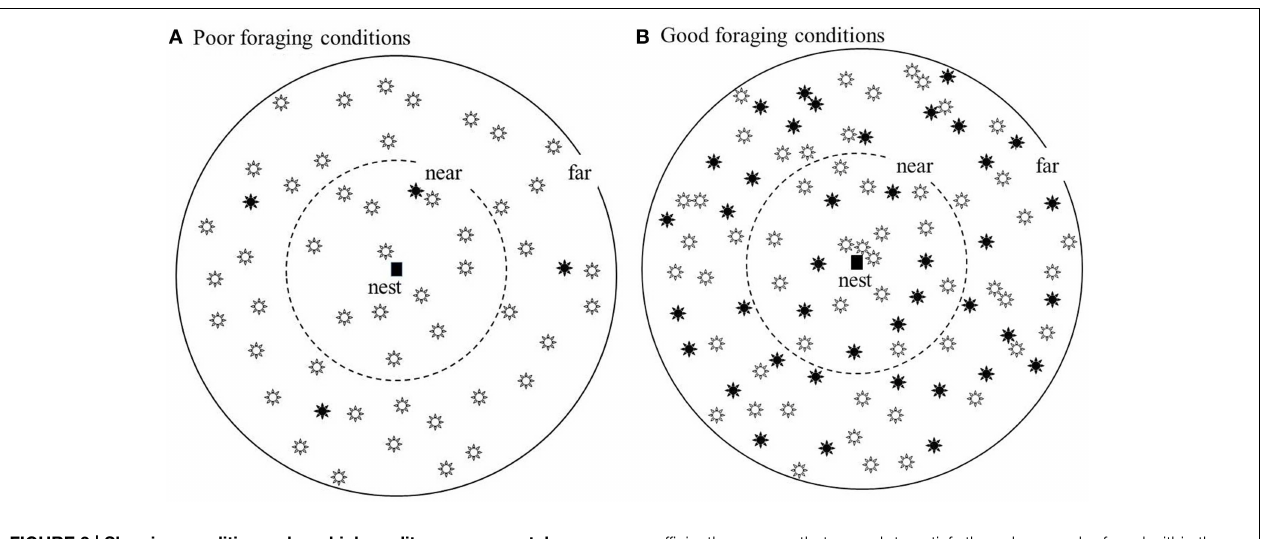
FIGURE 3 | Showing conditions where high quality resource patches, filled flowers, are scarce (A) or common (B); low quality resource patches are shown as open flowers. In (B) , high quality patches are